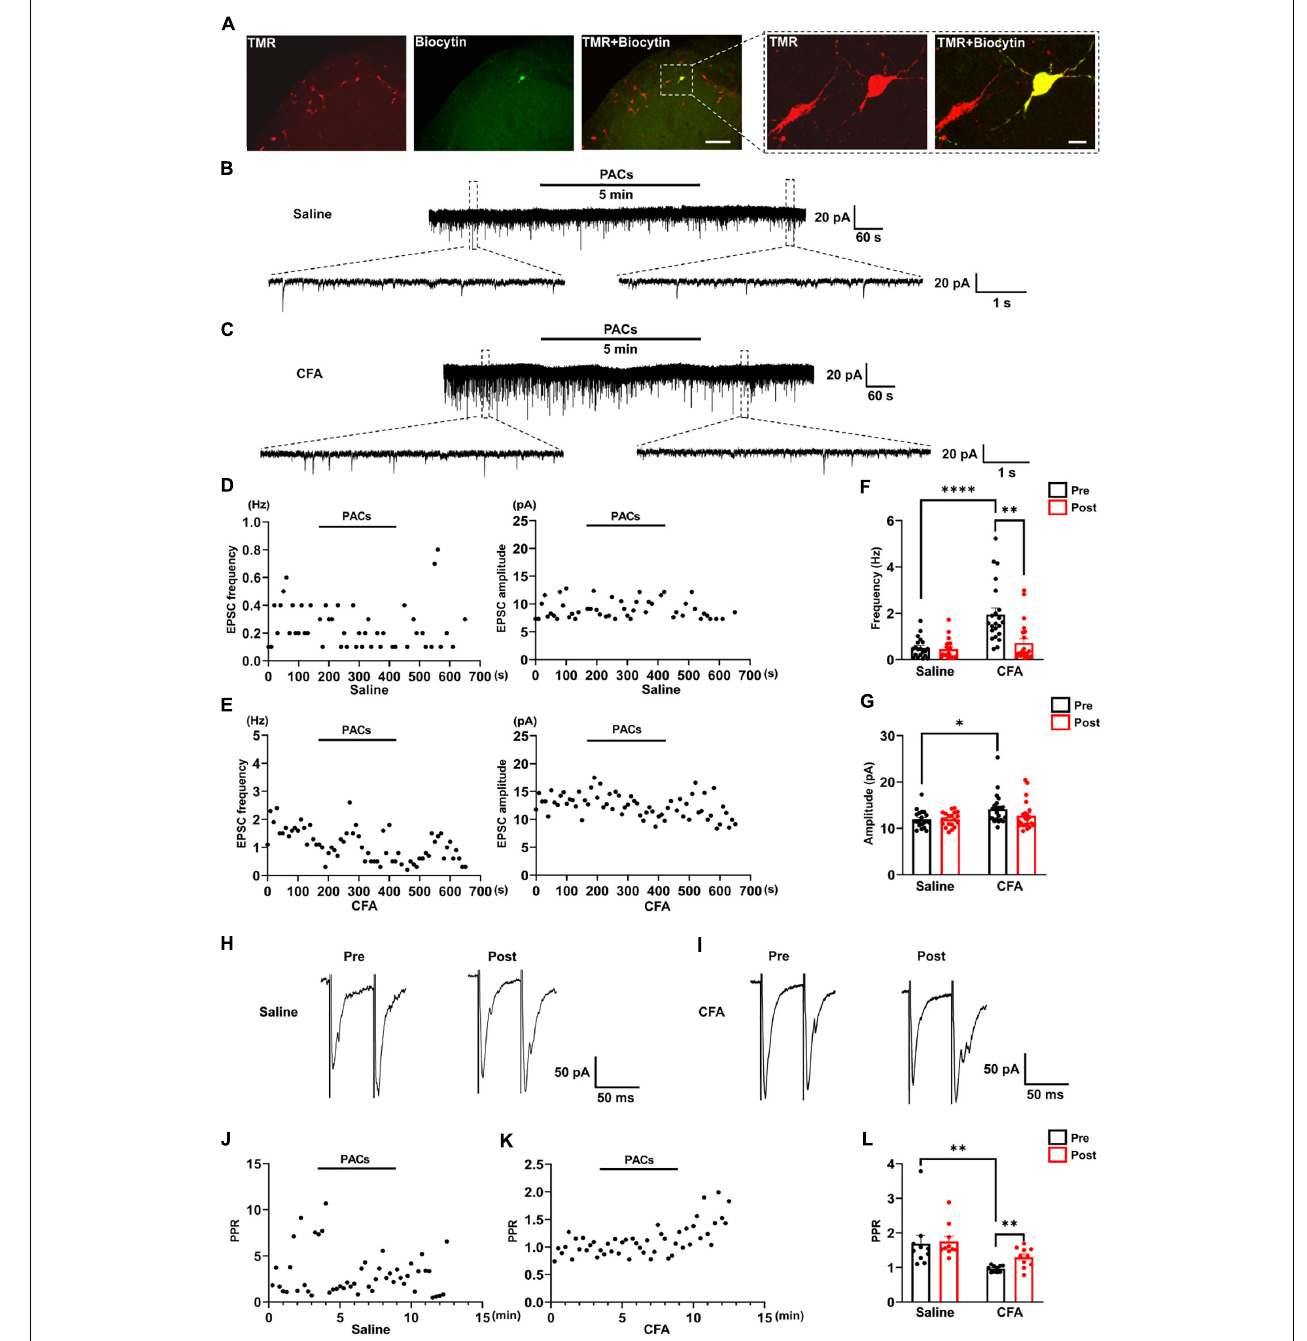
FIGURE 2 | The effect of proanthocyanidins on sEPSCs of PBN-projecting neurons in the spinal dorsal horn. (A) Double-labeling immunohistochemistry staining confirmed that all recorded neurons were TMR-positive retrogradely labeled neurons (red) those distributed in laminar I of the left spinal cord. The rectangle area was enlarged in the right panel. The scale bars equal to 150 µ m in the left panel images and 30 µ m in the right panel images. Representative electrophysiological samples (B) and scatter plots (D) showing sEPSCs with bath application of proanthocyanidins (50 µ M) in the saline group. Representative electrophysiological samples (C) and scatter plots (E) showing sEPSCs with bath application of proanthocyanidins in the CFA group. (F) Application of proanthocyanidins decreased the frequency of sEPSCs in the CFA but not saline group. (G) Application of proanthocyanidins had no effect on the amplitude of sEPSCs in the CFA or saline group. Representative electrophysiological samples (H) and scatter plots (J) showing the PPR with bath application of proanthocyanidins in the saline group. Representative electrophysiological samples (I) and scatter plots (K) showing the PPR with bath application of proanthocyanidins in the CFA group. (L) Application of proanthocyanidins increased the PPR in the CFA but not saline group. ∗ P < 0.05; ∗∗ P < 0.01; ∗∗∗∗ P < 0.0001. TMR, tetramethylrhodamine; CFA, Complete Freund’s Adjuvant; PACs, proanthocyanidins; PPR, paired-pulse ratio.